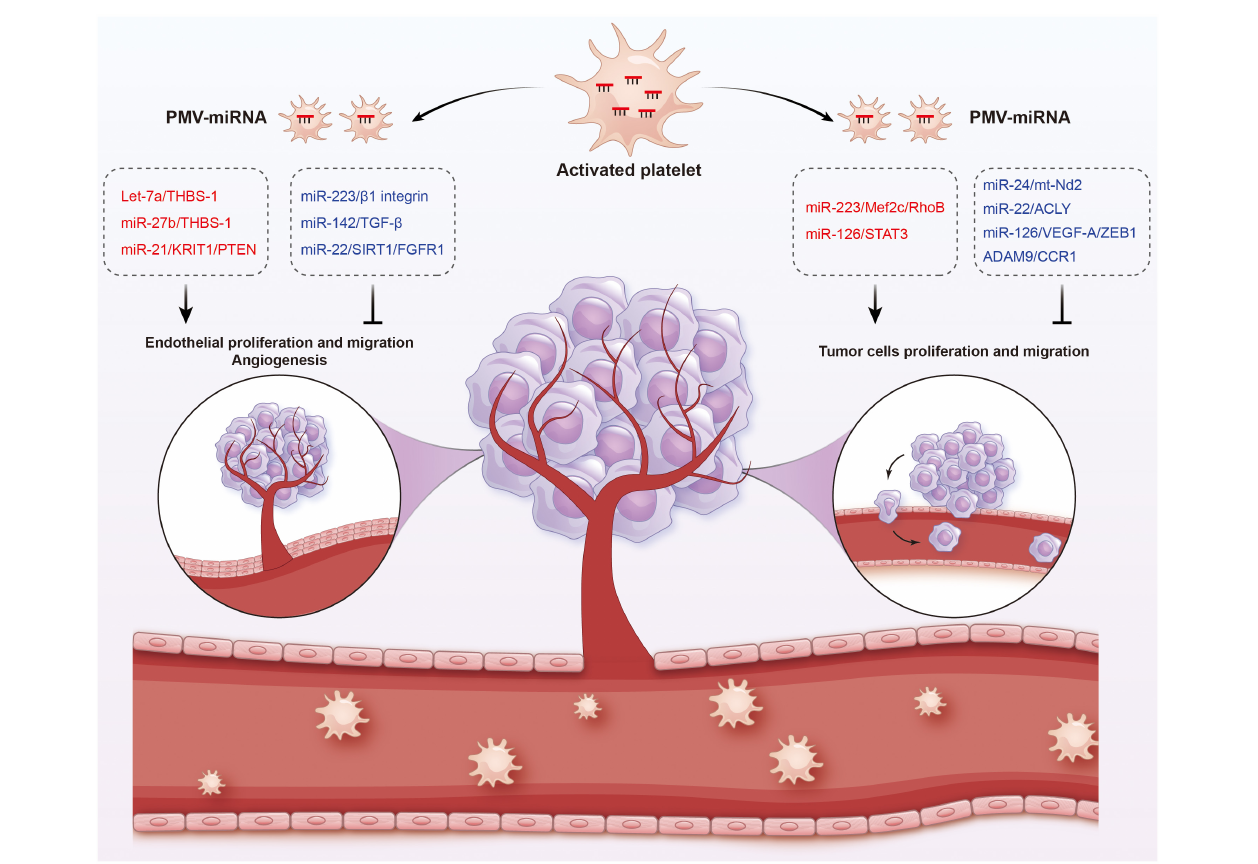
FIGURE 5 | Functions of platelet-derived miRNAs in cancer. Platelet-derived miRNAs change tumor fates in two ways: on the one hand, PMVs transfer platelet miRNAs to vascular endothelial cells and are associated with enhanced tumor metastasis and cancer progression; on the other hand, PMVs can penetrate the blood vessels and enter the tumor microenvironment to directly transfer platelet miRNAs into tumor cells, thus regulating gene expression in tumor cells and tumor progression. The red represents miRNA-mRNA pairs that produce promoting functions and the blue represents miRNA-mRNA pairs that produce inhibitory functions. Abbreviations: THBS-1, anti-angiogenic protein thrombospondin-1; KRIT1, krev interaction trapped protein 1; PTEN, phosphatase and tensin homolog deleted on chromosome ten; TGF- β , transforming growth factor β ; SIRT1, sirtuin 1; FGFR1, fibroblast growth factor receptor 1; Mef2c, myocyte enhancer factor 2C; STAT3, signal transducer and activator of transcription 3; ACLY, proto-oncogene ATP citrate lyase; VEGFR-A, vascular endothelial growth factor receptor A; ZEB1, zinc finger E-box binding homeobox 1; CCR1, chemokine (C-C motif) receptor